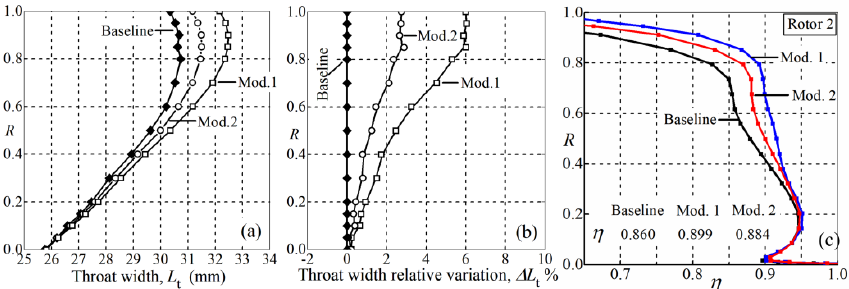
Figure 9. The Rotor 2 blade passage throat width L t ( a ), relative variation ∆ L t ( b ) and isentropic efficiency (cid:2015) ( c ) of baseline, Mod.1 and Mod.2.